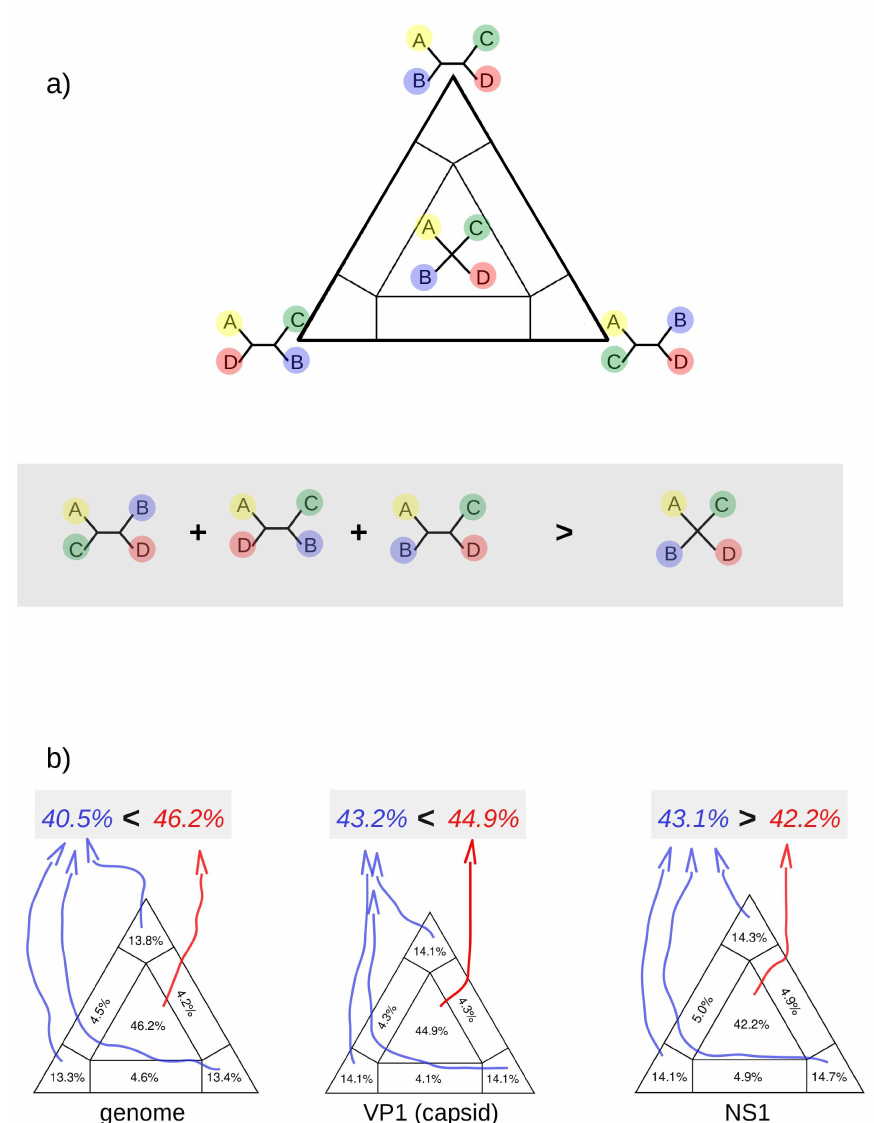
Figure 3. Maximum likelihood map. ( a ) Schematic representation of the maximum likelihood map approach. In the triangular surface, individual likelihoods of all possible quartets will be plotted. trees will occupy the center of the surface. Alignments with proper phylogenetic signals